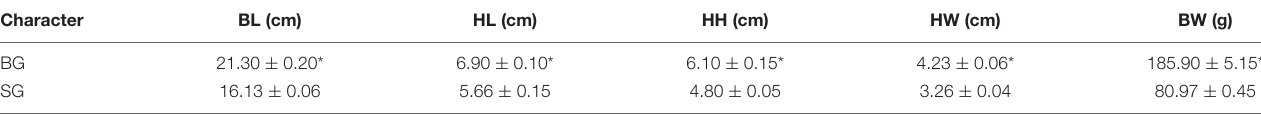
TABLE 1 | Phenotype differences of bighead carp between big and small groups.